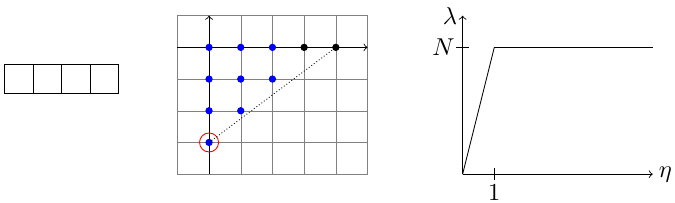
(a) The maximal puncture with G F = SU( N ) , corresponding to the box diagram Y ‘ with ‘ = N . Here, p ‘ = ‘ − 1 , such that p ‘ = { 0 , 1 , 2 , 3 } in the above diagram (allowing ‘ = 1 , . . . , N ).